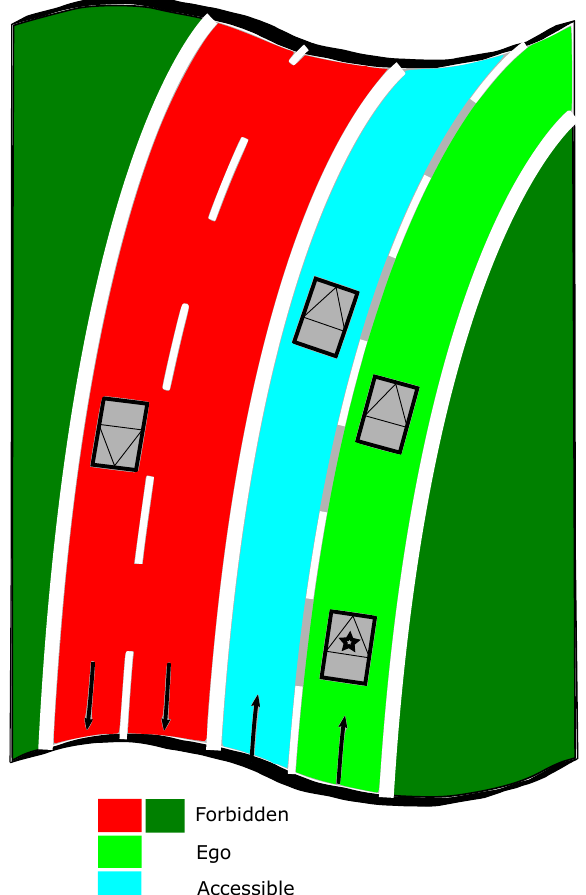
Figure 1. The lane state depends on the host vehicle position depicted with a star. Ego lane in bright green, Accessible lane in cyan, the Forbidden areas in red and dark green.